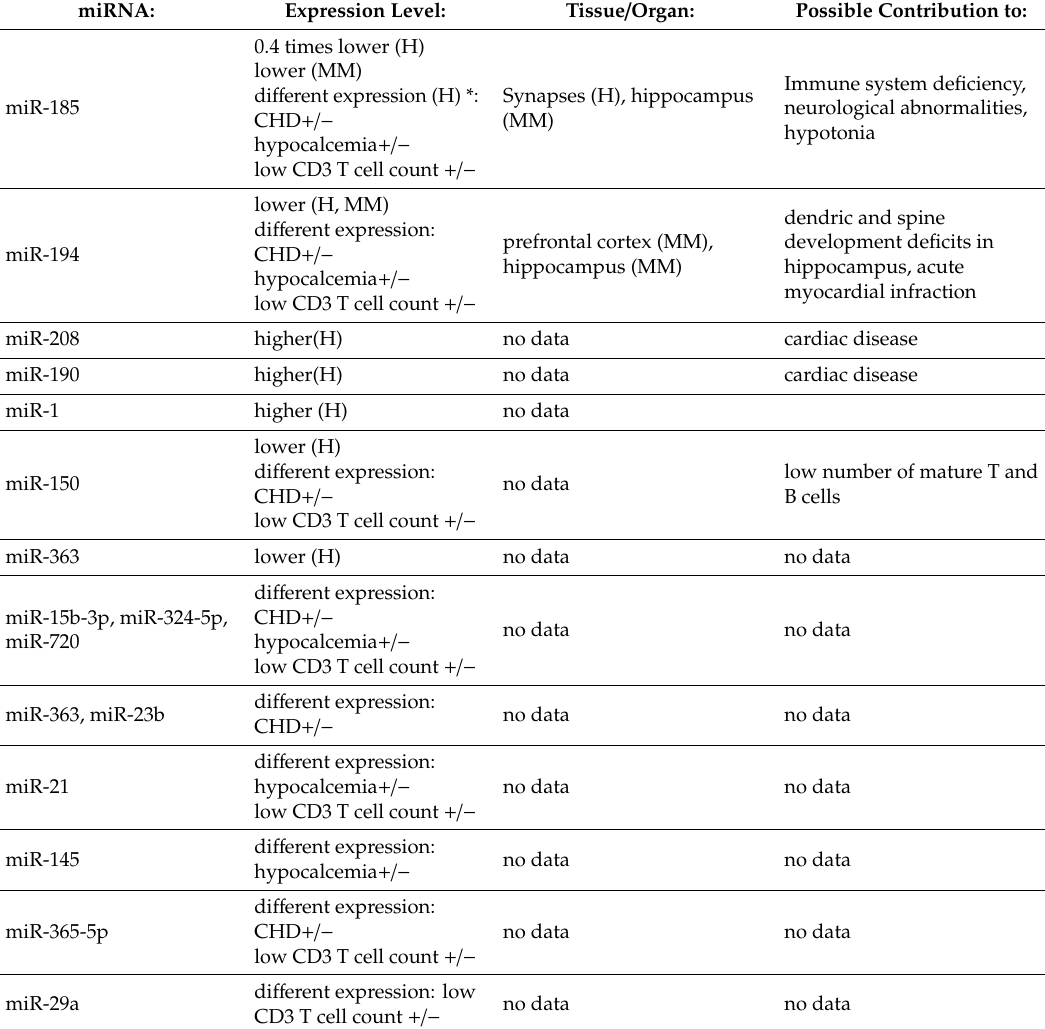
Table 1. MicroRNA expression dysregulation in 22q11.2 patients and mouse model [41,42]. miRNA located on 22q.11.2 locus in